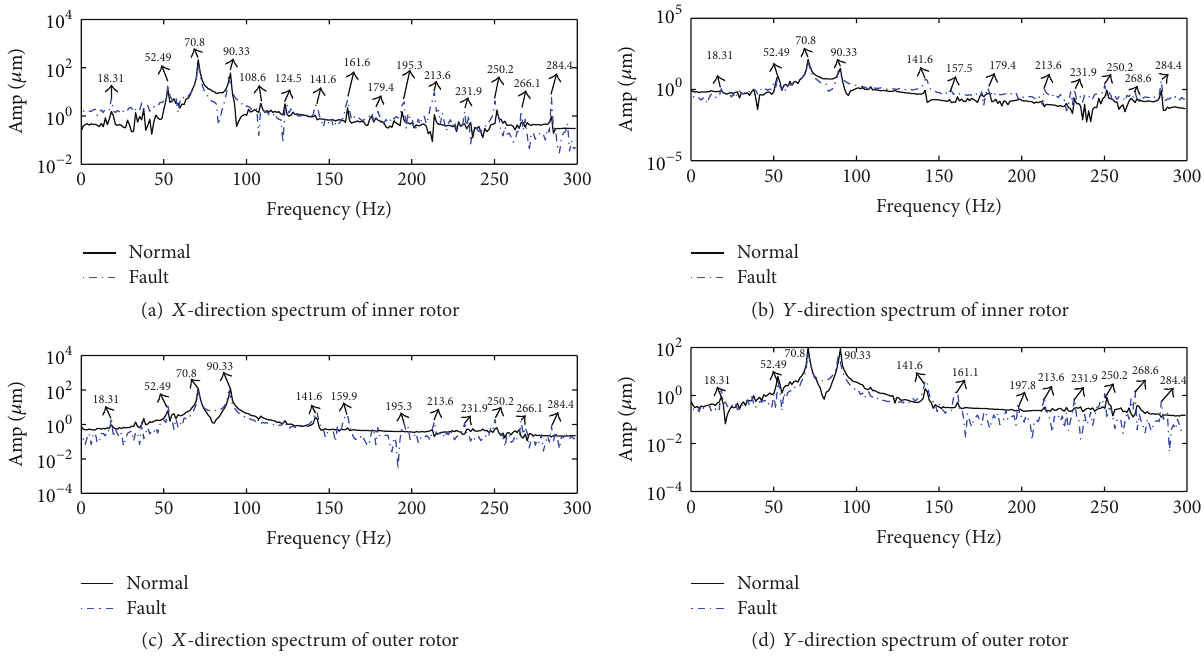
Figure 11: The vibration displacement spectrums of 𝑋 direction and 𝑌 direction.